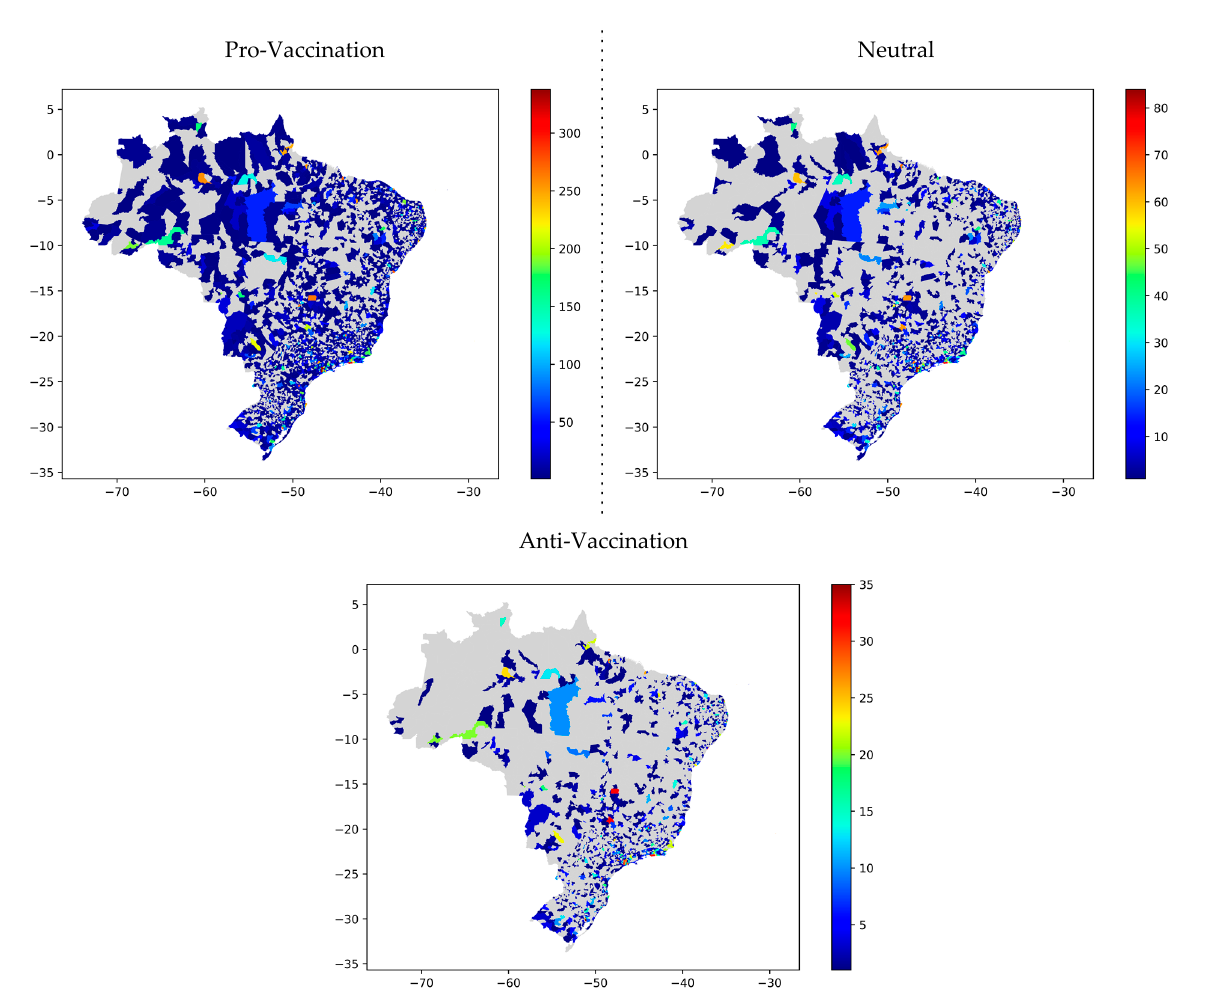
Figure 12. Topic 13 distribution on the Brazilian territory. From the topic polarity annotation, in addition to analyzing the evolution of these polarities over 17 months, it is possible to visualize the geographic distribution of tweets according to the labels applied. The grid in Figure 13 contains maps according to polarity, making the distribution of tweets per city.